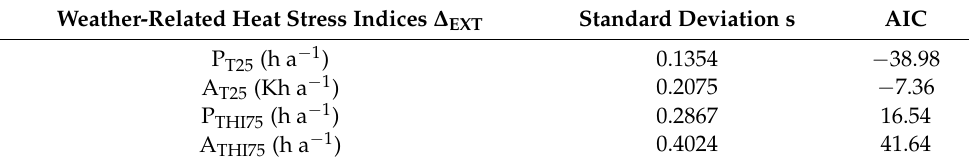
Table 5. Standard deviation s of the detrended (and logarithmically transformed) weather-related heat stress indices ∆ EXT and the Akaike information criteria